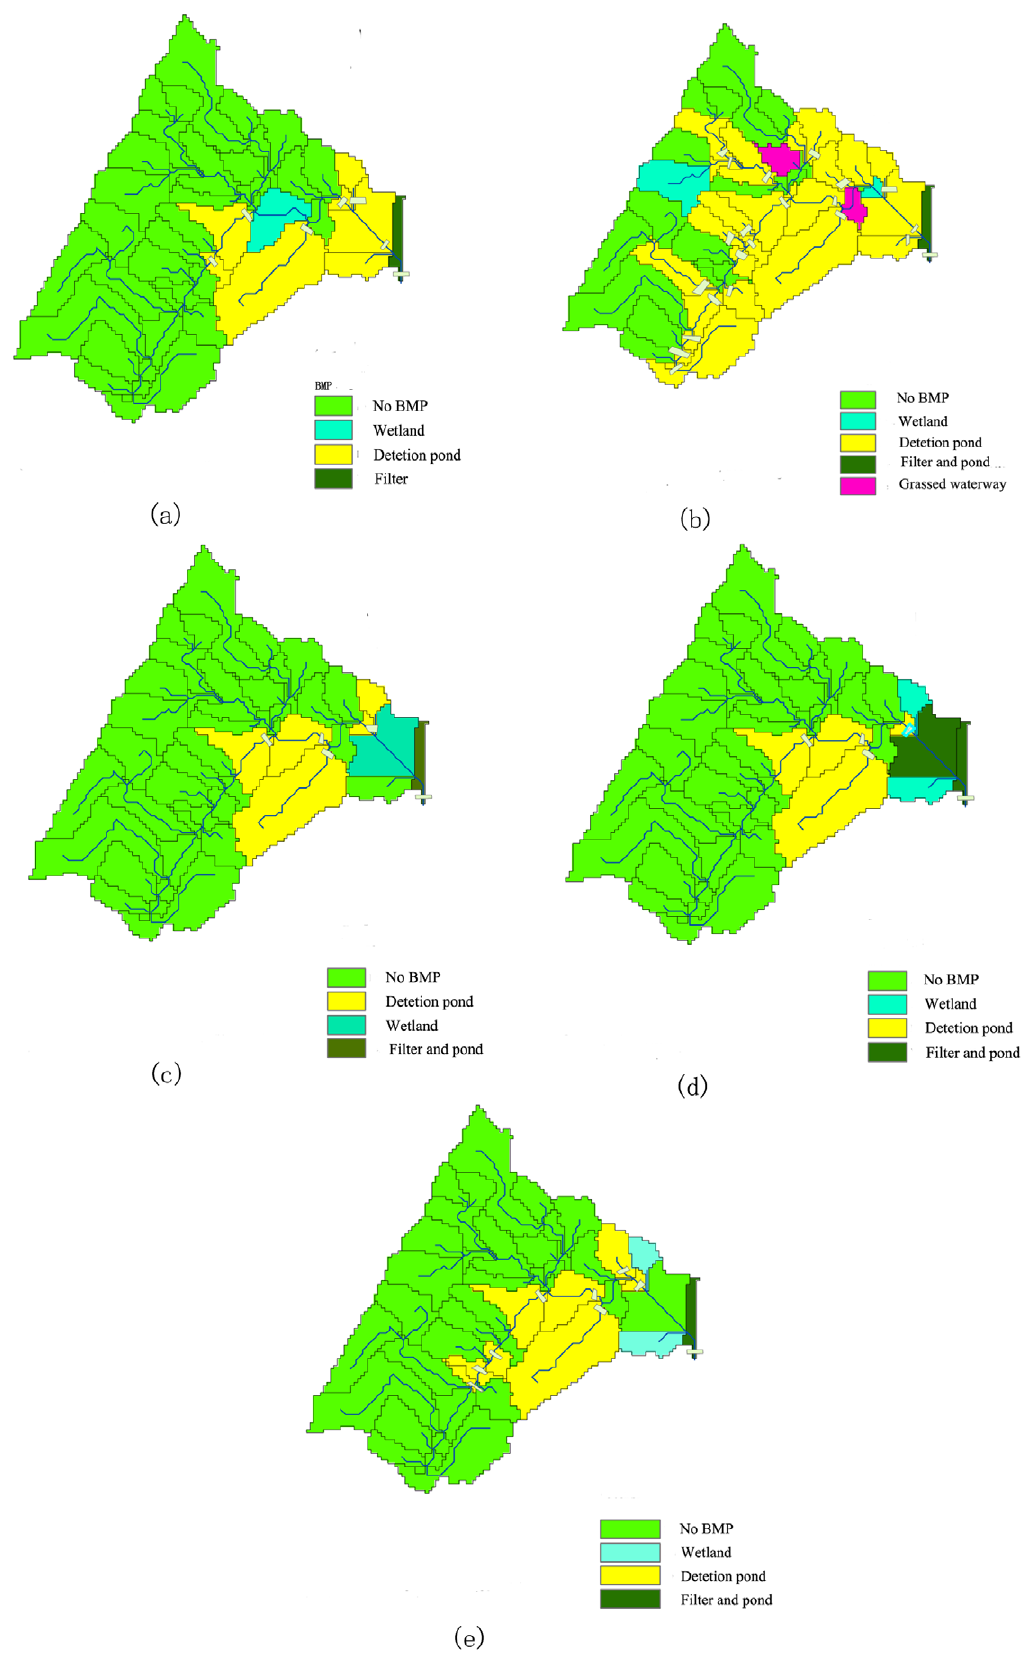
Figure 7. The spatial distribution of the structural BMPs for each optimization scenario. doi:10.1371/journal.pone.0054520.g007 PLOS ONE |